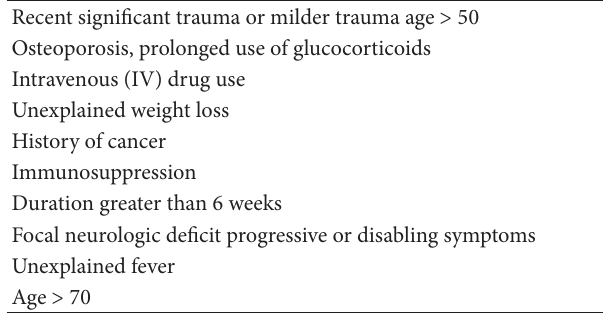
Table 1: “Red flags” for a potentially serious underlying cause for low back